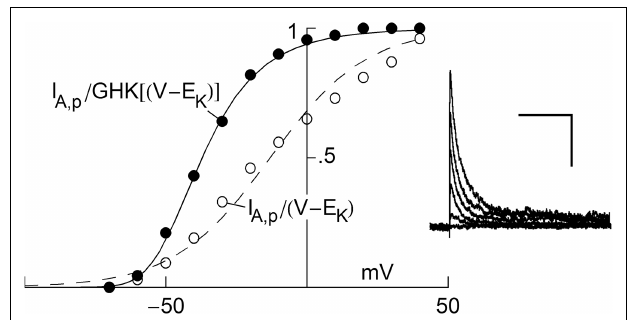
FIGURE 3 | GHK analysis of I . The records in the right were taken from A (Mienville et al., 1999). The scales correspond to 100 ms and 400 pA. The open circles in the graph correspond to peak I at the respective potential on the A x -axis divided by ( V − E ) where E = − 96 mV. The fi lled circles represent peak K K I divided by GHK[( V − E )] – Eq. 3 in the text. The dashed line corresponds to A K 1/(1 + exp(( V − V )/ k )), where V = − 17 and k = − 18 mV. The solid line 1/2 1/2 + β corresponds to ( α /( α )) 3 , where α = − 0.01 ( V + 51)/(exp( − 0.1( V + 51)) − 1) n n n n and β = 0.125 exp( − ( V + 61)/25). n